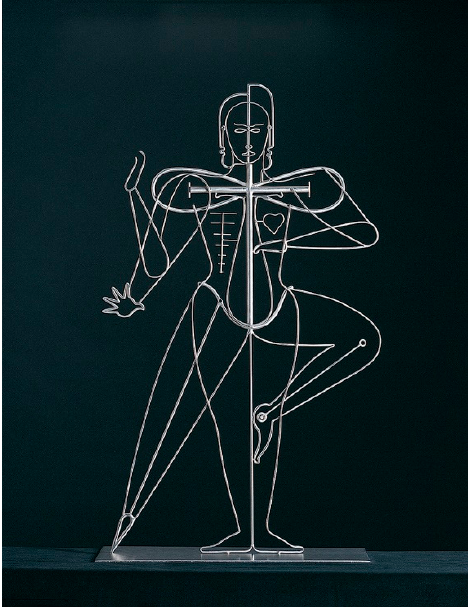
Figure 11. Les signes de l’Homme (Dématérialisation) by Oskar Schlemmer, 1924/1986. © 2016 Oskar Schlemmer, Photo Archive C. Raman Schlemmer and used by permission.